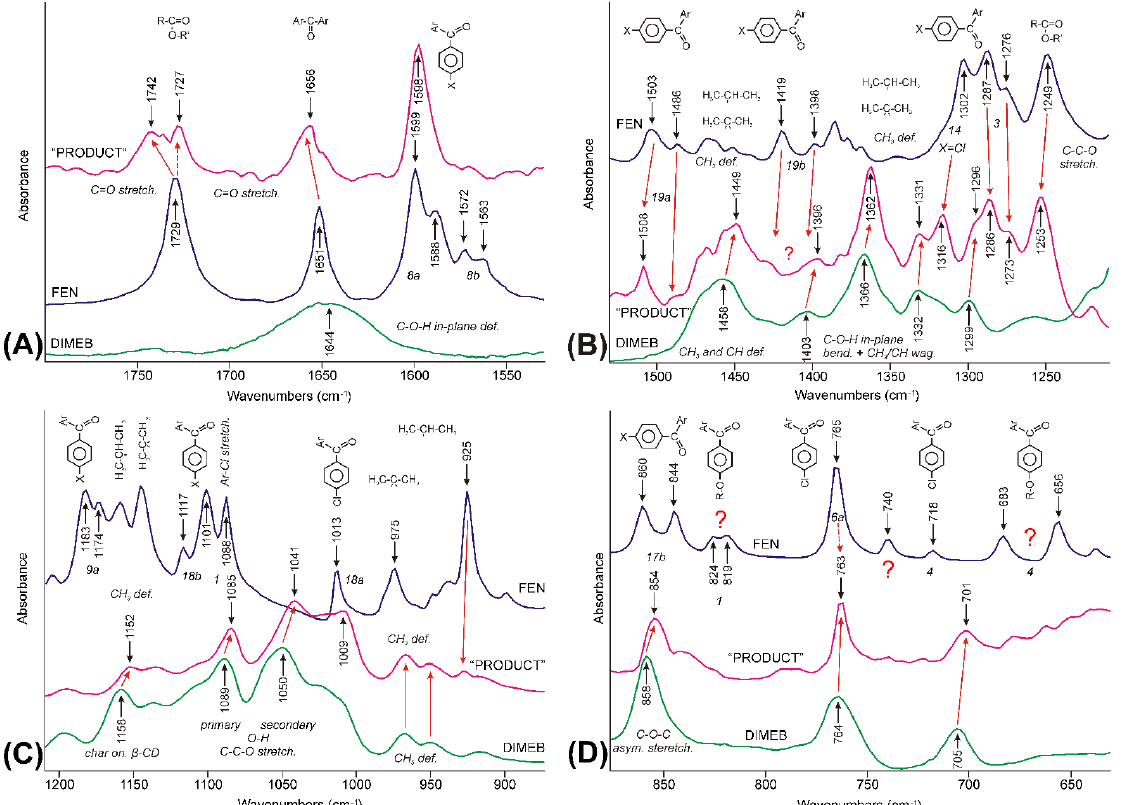
Figure 11. Comparison of IR-ATR spectra of FEN (purple line), DIMEB (green line), and “PRODUCT” (magenta line), in the 1800–630 cm − 1 spectral range, which was divided into four parts ( A – D ). Red arrows show interpretation of the peaks of the raw materials shifted and widened. The vibrations that were impossible to identify, marked with question marks.